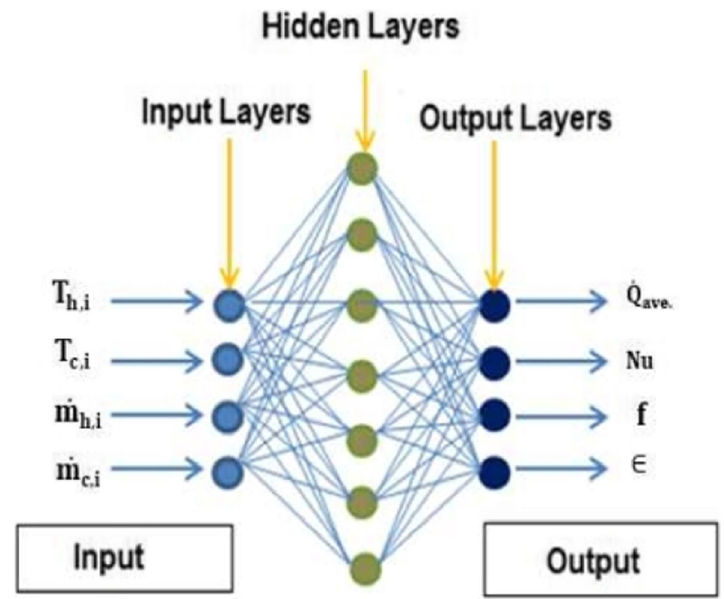
Fig. 7 Architecture of artificial neural network